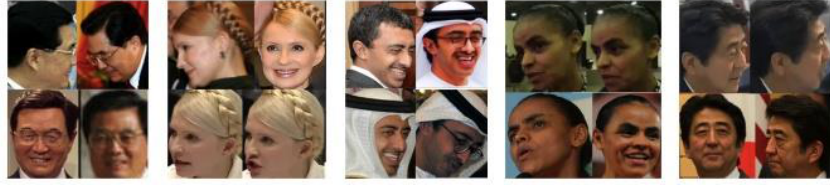
Figure 12. Examples of the faces in the IJB-A (Janus Benchmark A) database.